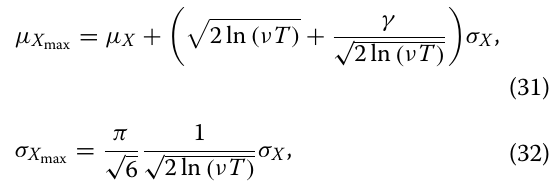
Figure 14 Standard deviation of maximum value of load reduction factor (turbulent